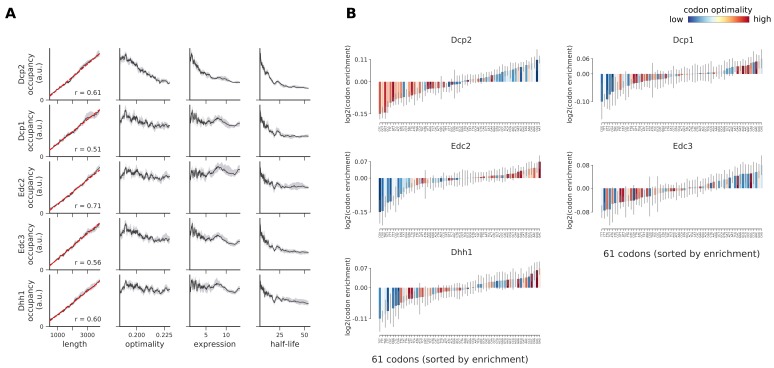
Occupancies of decapping factors (Dcp2, Dcp1, Edc2, Edc3, and Dhh1) compared to transcript length, optimality, expression level, and half-life.(A) To understand binding specificity of decapping factors, the total occupancy of each factor on a transcript is plotted against various transcript features (Gray shading: 95% confidence intervals generated by bootstrapping transcripts). (B) Same analysis as in Figure 6B: Codon enrichment shows deviations in codon frequencies of transcripts bound by a degradation factor compared to each codon’s frequency on all coding sequences. Each bar is colored according to its codon-optimality with highly optimal codons in dark red and highly non-optimal codons in dark blue. (Gray lines: 90% confidence intervals generated by bootstrapping coding sequences).